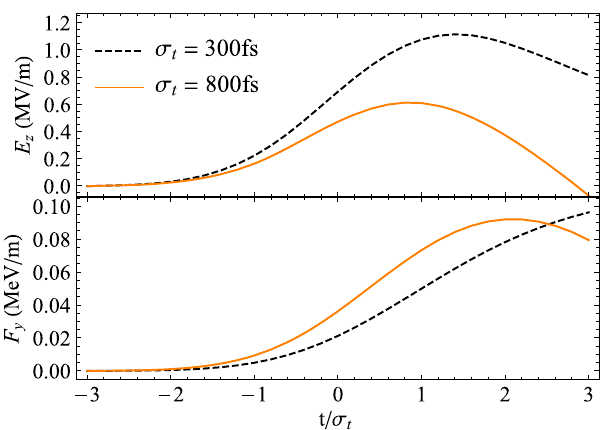
FIG. 3. Comparison of simulated longitudinal E z (top) and vertical F y (bottom) wakefields for an 85-pC Gaussian bunch with lengths σ t ¼ 800 and 300 fs, and σ x ¼ σ y ¼ 150 μ m. The longitudinal coordinate is normalized to the bunch σ t and the F y field is plotted at y ¼ 2 σ y ¼ 300 μ m. The DWA structure half- gap is a ¼ 1